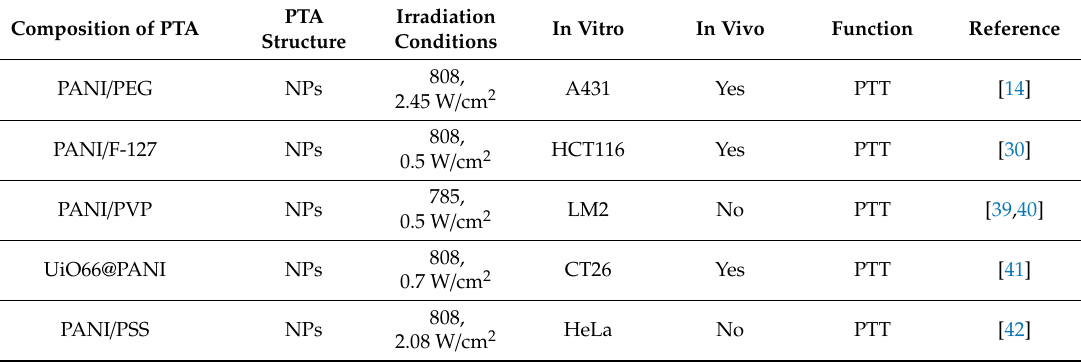
Table 1. Summary of PANI-based photothermal agents for cancer treatments.